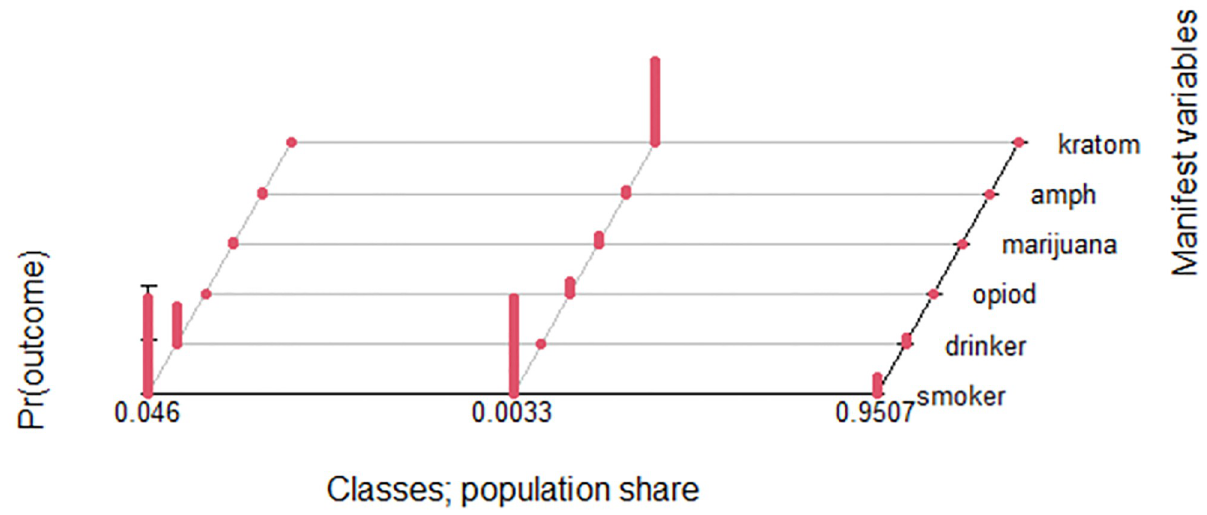
Fig 1. Estimates class population